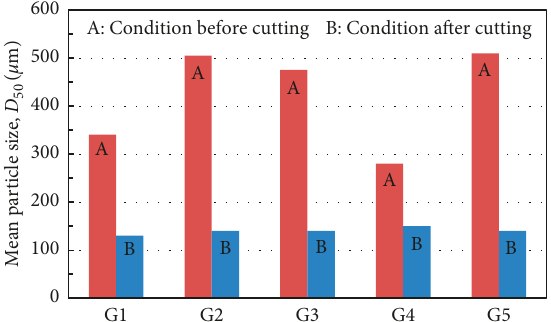
Figure 11: Mean particle size comparison before and after cutting for the five garnet